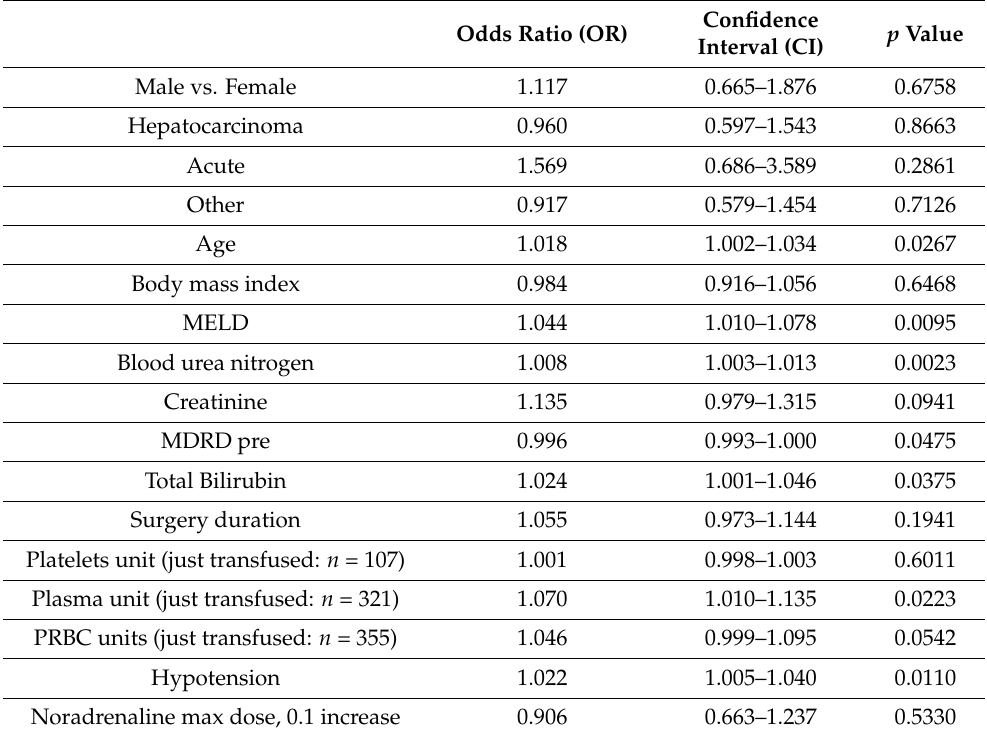
Table 2. Logistic regression analysis of all preoperative and intraoperative factors. MELD: Model for End-stage Liver Disease; MDRD: Modification of Diet in Renal Disease; PRBC: packed red blood cells. Confidence p Value Odds Ratio (OR) Interval (CI) Male vs. Female 1.117